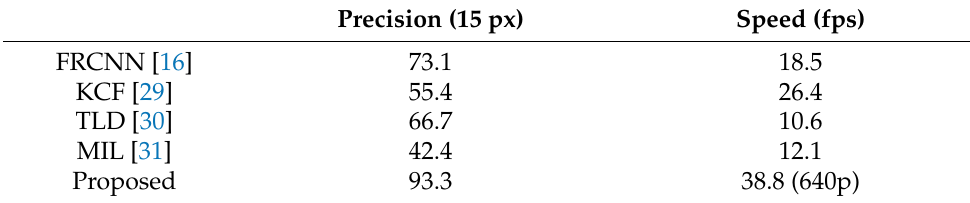
Figure 14. Examples of the proposed fingertip detection on: ( a ) the EgoFinger dataset; and ( b ) our synthetic dataset. Table 3. The results of precision and